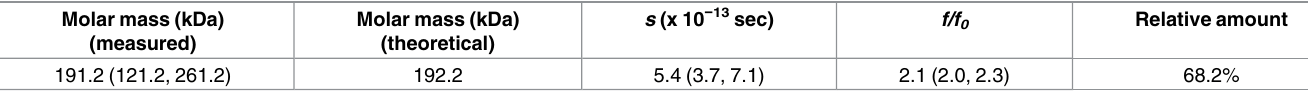
Table 2. Integration results from the PCSA-DS.